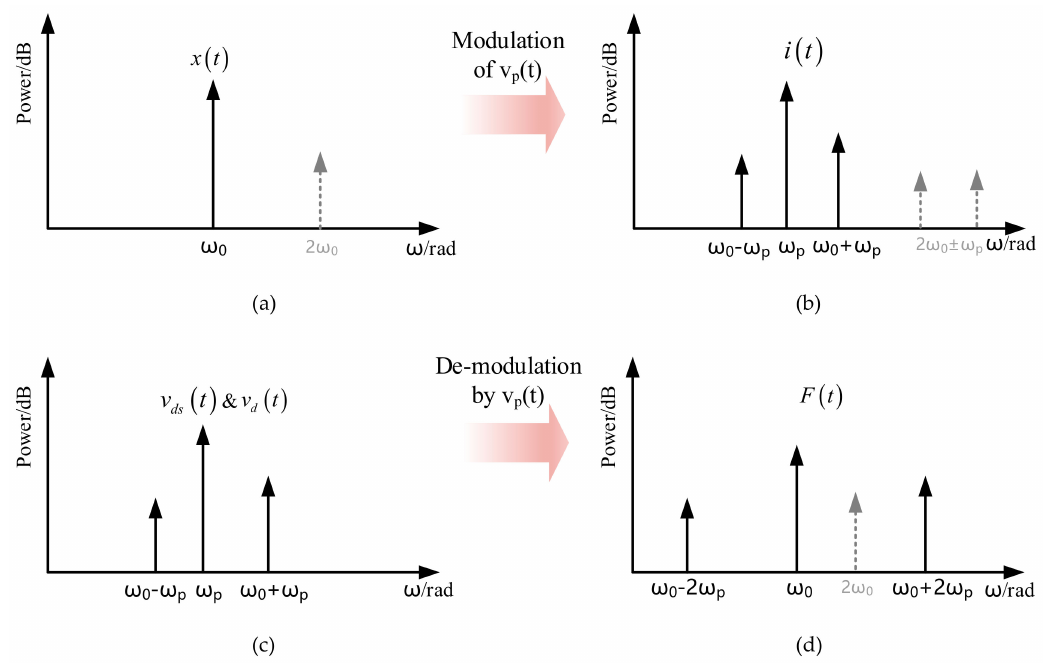
Figure 5. Frequency spectrums of ( a ) oscillation displacement ( b ) motional current ( c ) detection / drive voltage and ( d ) drive force in a MEMS resonator adopting AC polarization. Di ff erential detection topology is assumed to cancel the feedthrough at ω p after the amplification of